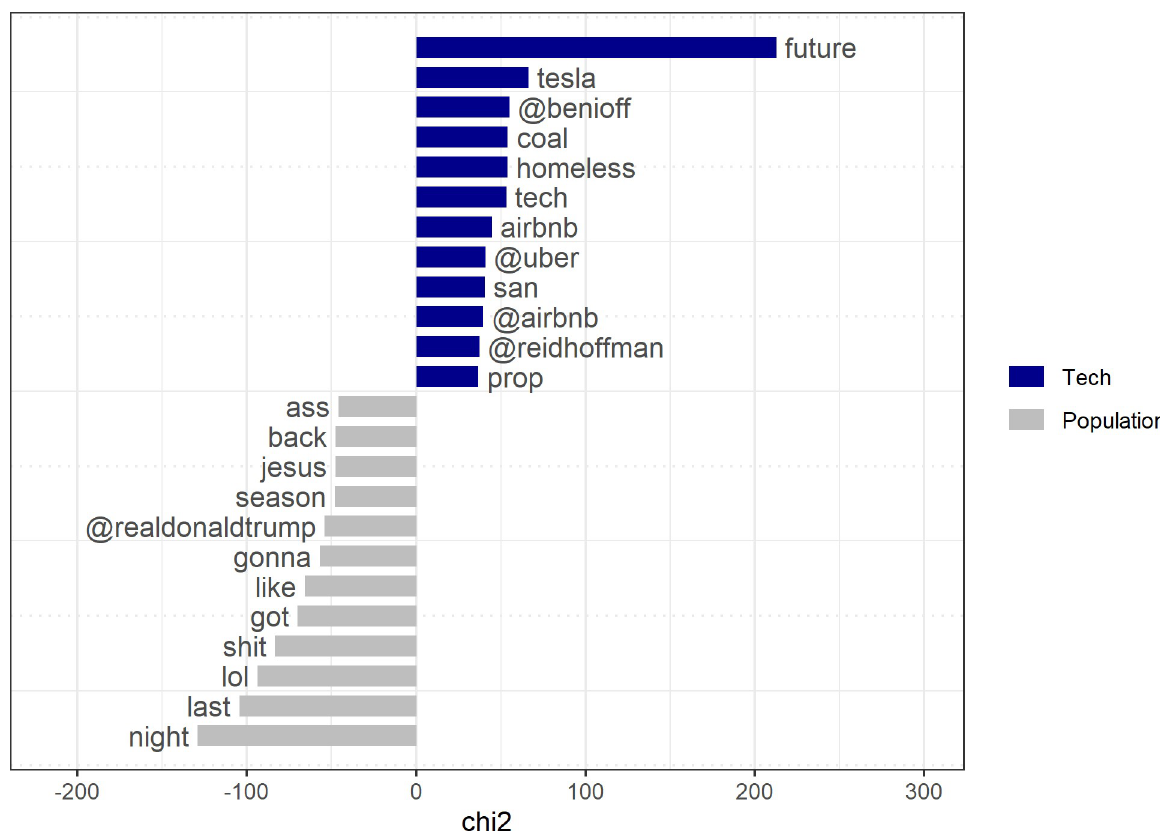
Fig 4. Keyness statistics for tweets with future-related